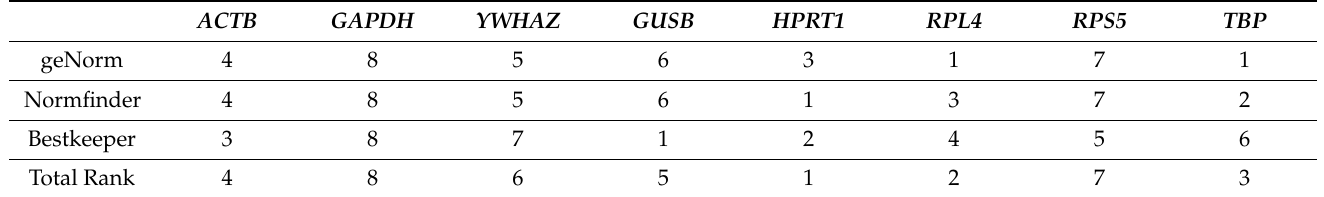
Table 3. Rank of reference gene stability all